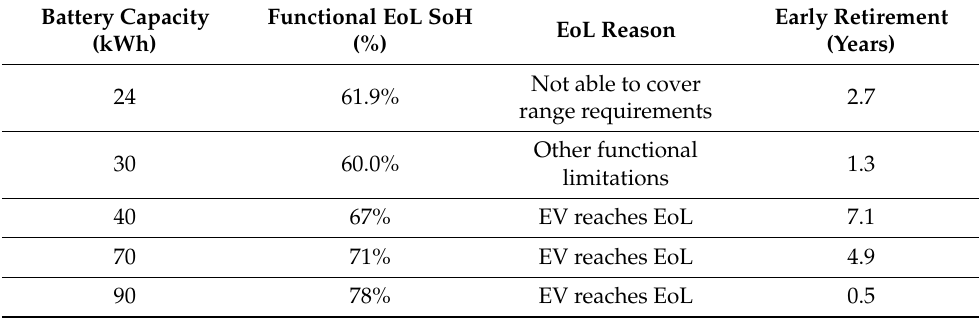
Table 5. Functional EoL and assumed early retirement from the